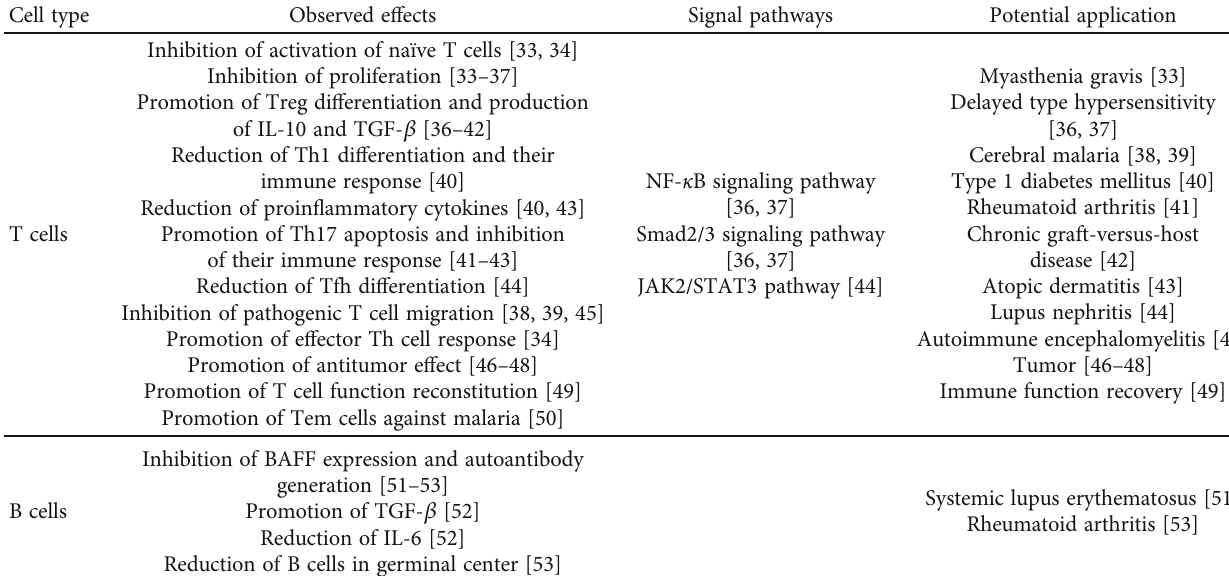
Table 2: E ff ects of artesunate on adaptive immune cells and potential